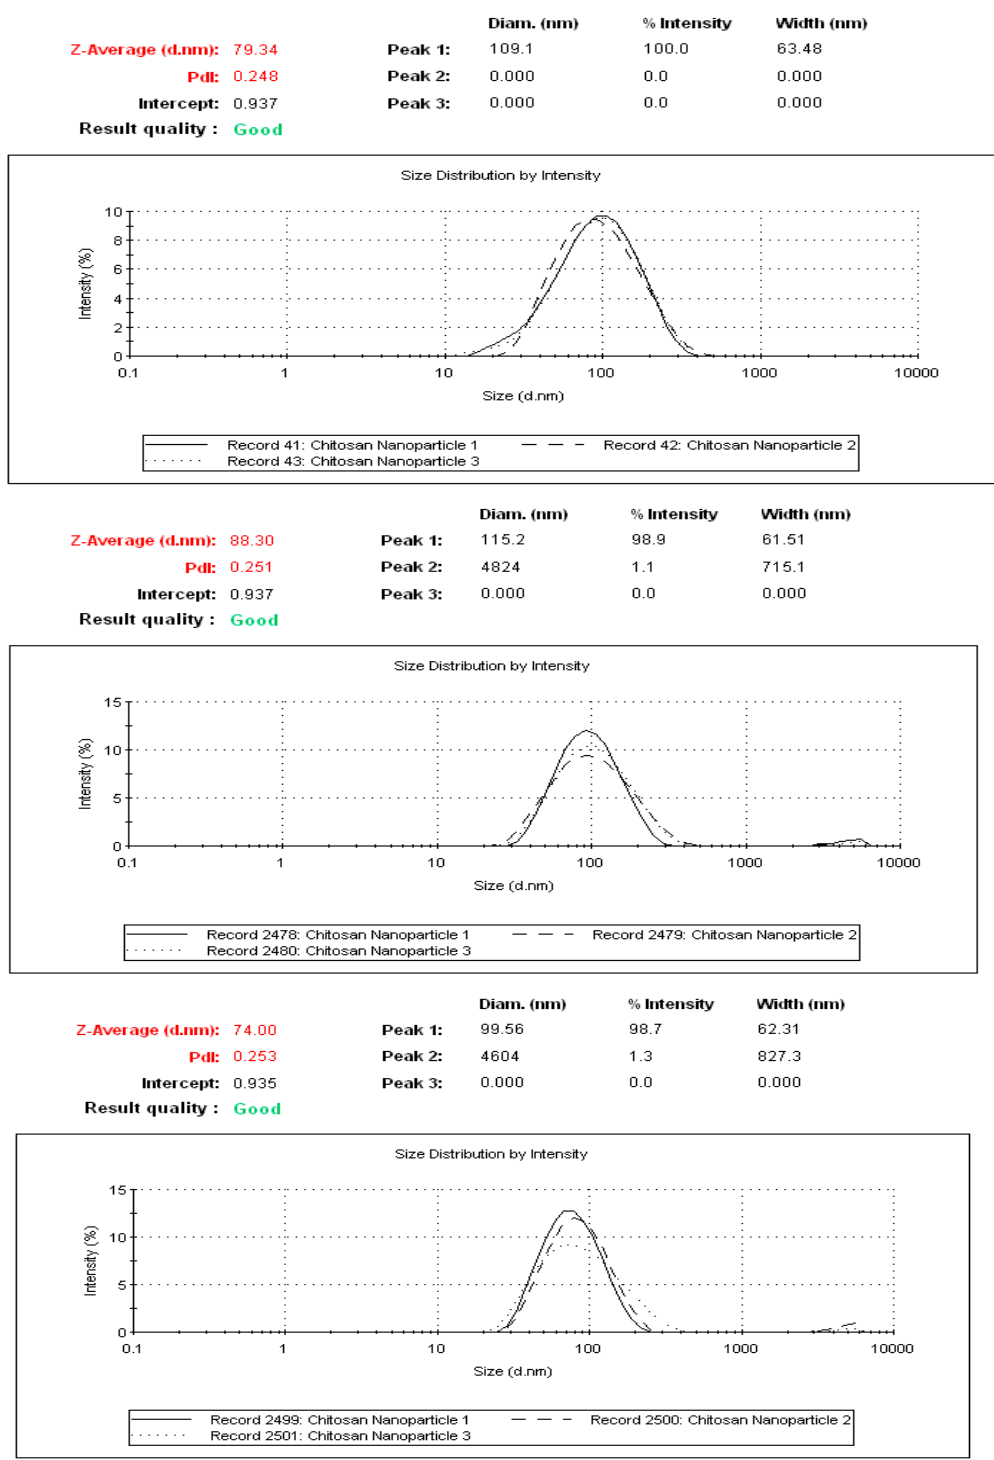
Figure 3. Reproducibility of DLS analyses for the optimal parameter, CNP ◦ using 600 µ L CS (0.5 mg / mL) and 200 µ L TPP (0.7 mg / mL). Consistency in synthesizing nanoparticle with average 80.89 ± 5.16 nm with PDI value of 0.26 ± 0.01 were observed in all three replicates; showing that at this parameter, stable and monodispersed CNP ◦ were consistently able to be synthesized.